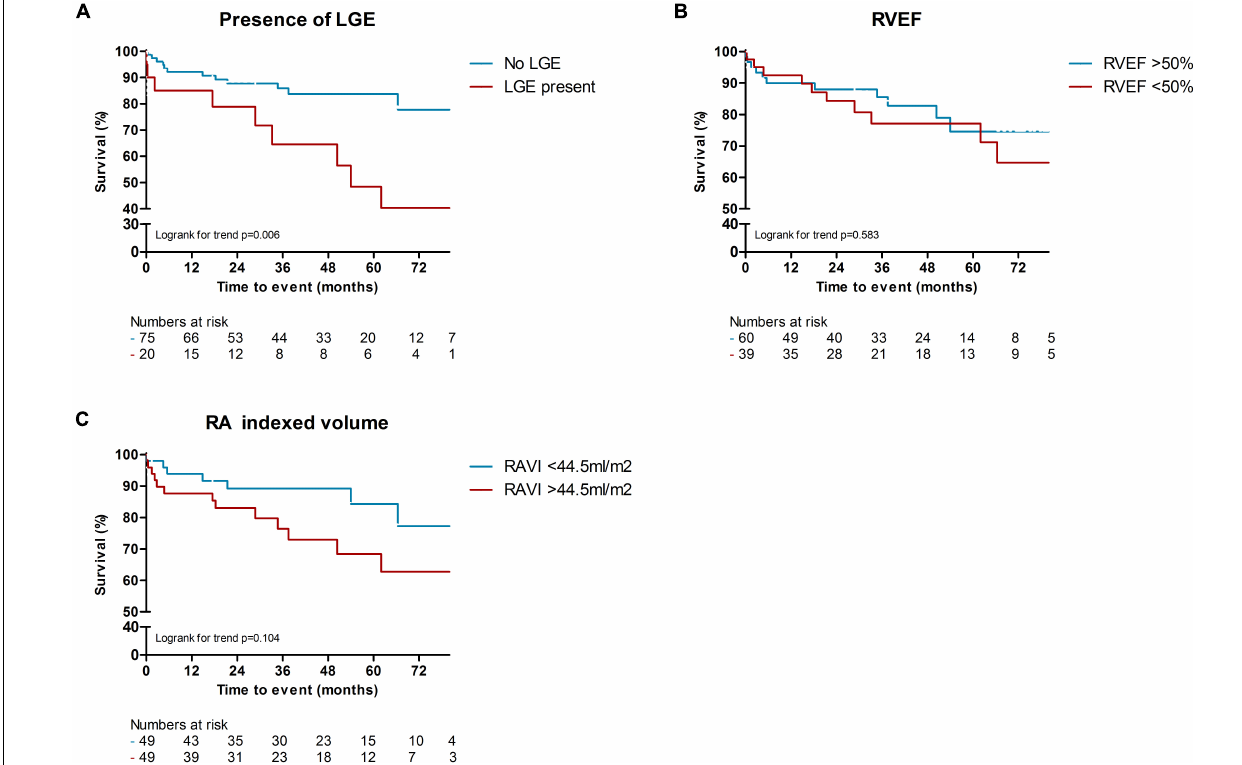
FIGURE 2 | Kaplan-Meier survival analysis of LGE, RVEF, and RA indexed volume. Presence of LGE was associated with higher rates of all-cause mortality, compared to patients without any LGE [ p = 0.006, (A) ]. Compared to SSc patients with preserved RVEF ( > 50%), patients with reduced RVEF ( < 50%), did not have a worse prognosis [ p = 0.583, (B) ]. A higher RA indexed volume ( > 44.5 ml/m 2 ) was also not significantly associated with worse all-cause mortality [ p = 0.104, (C) ]. LGE, late gadolinium enhancement; RVEF, right ventricular ejection fraction; RA (VI), right atrial (volume indexed).